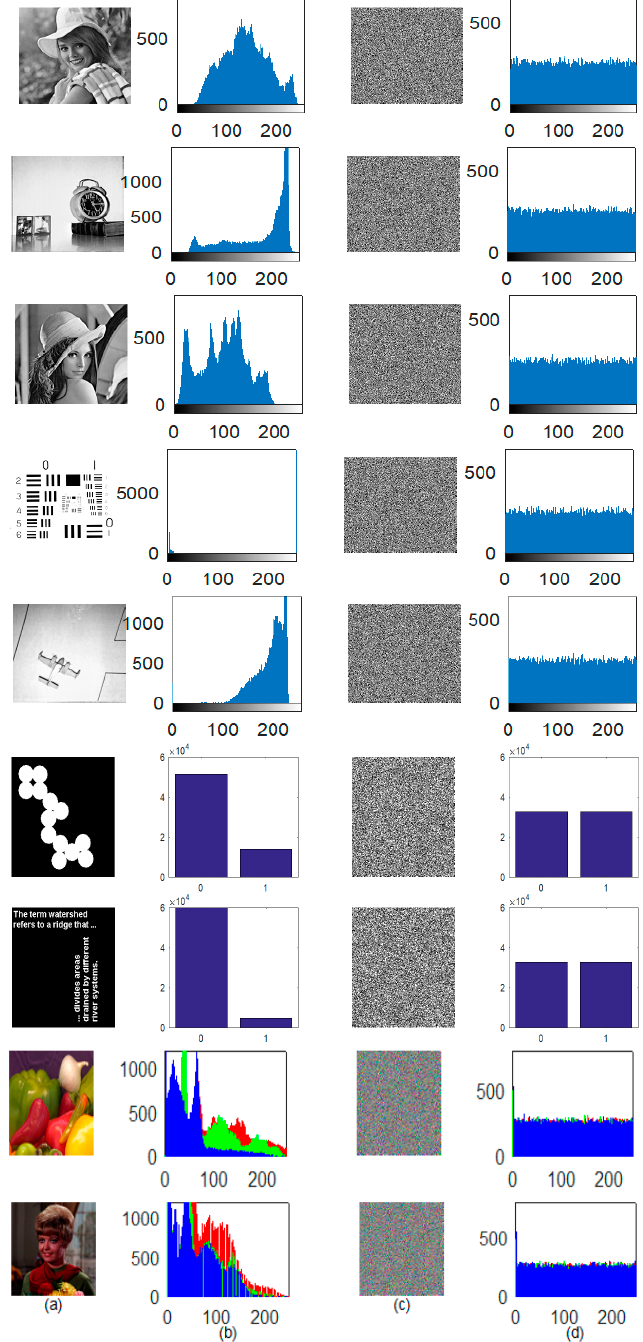
Figure 10. ( a ) Plain image; ( b ) Histogram of ( a ); ( c ) Cipher image; ( d ) Histogram of ( c ).